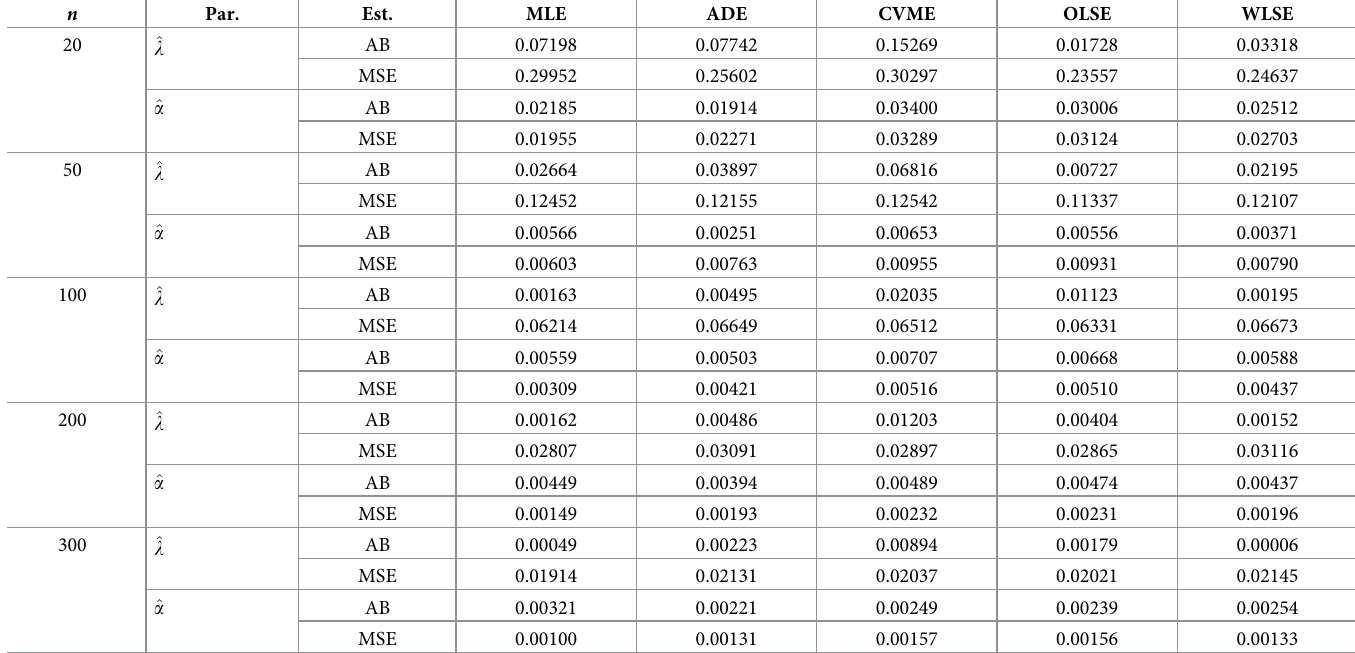
Table 3. Simulation results for ( λ = -0.5, α = 0.5). n Par.